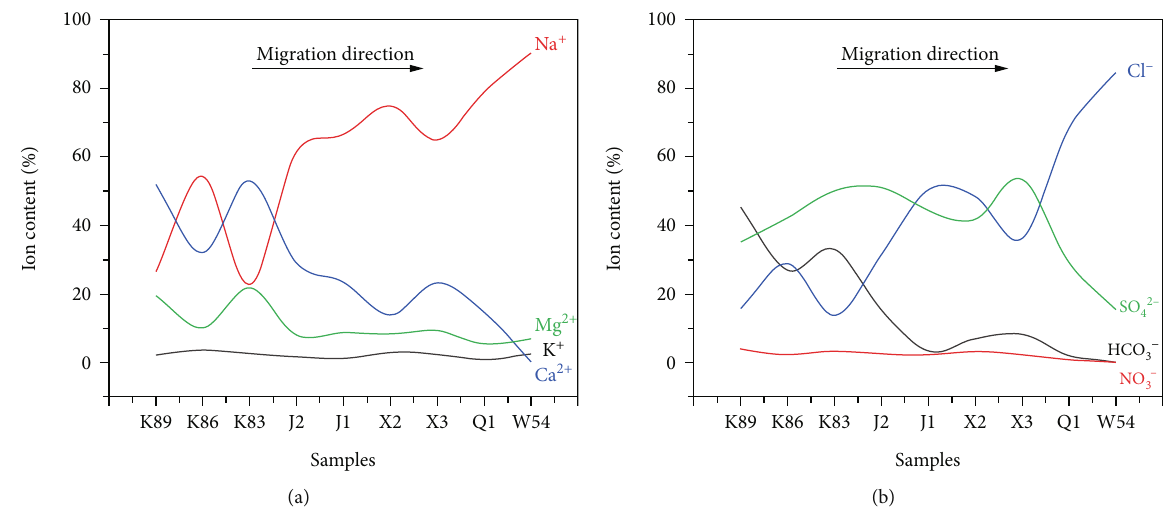
Figure 3: Variations of anion and cation proportions in water with water migration ((a) cations and (b) anions). Table 3: Sample sources, B contents, and B isotopic composition in the water